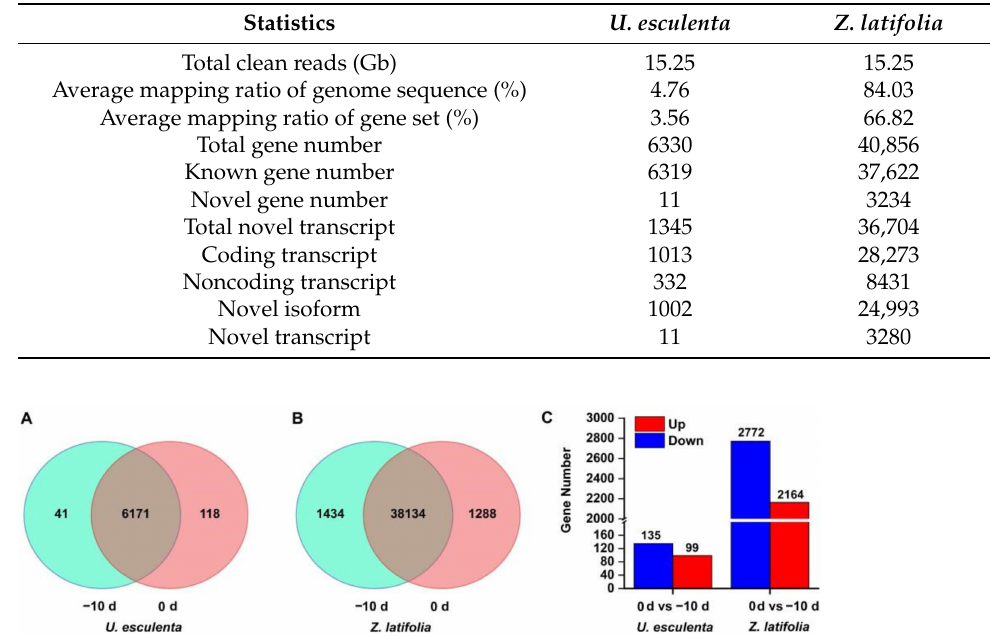
Figure 3. Transcriptome profiles of the gene expression patterns of Z. latifolia and U. esculenta in the initial stage of stem-gall formation. The number of common genes, specific genes of U. esculenta ( A ) and Z. latifolia ( B ), and DEGs in both interacting organisms ( C ) between − 10 d and 0 d of stem-gall